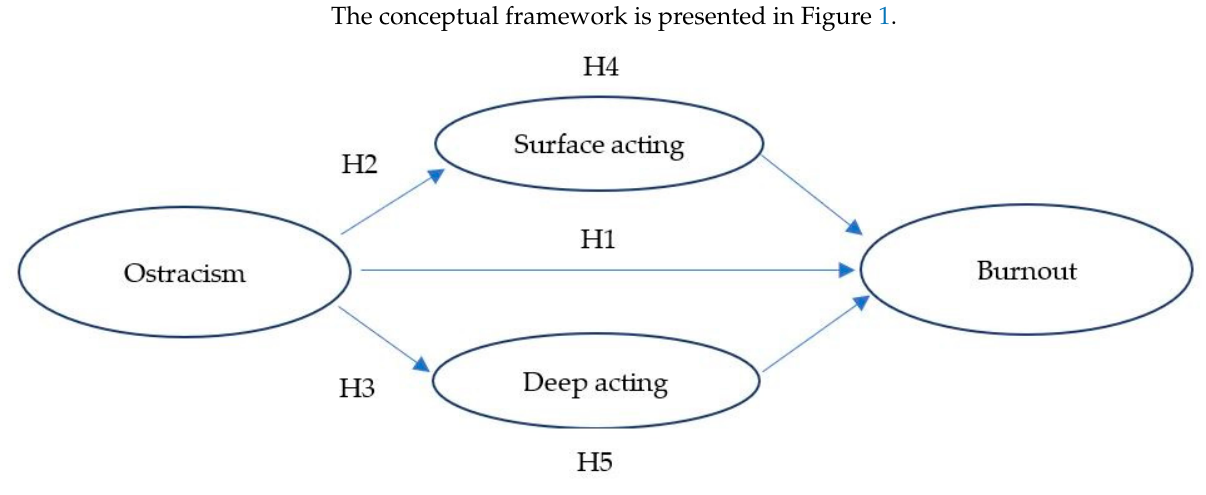
Figure 1. Hypothesized